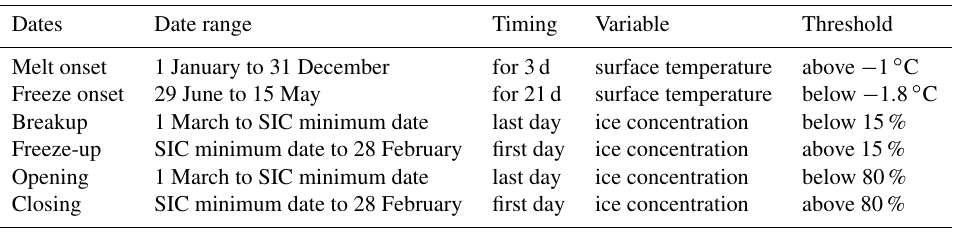
Table 1. Definitions of the seasonal transition dates, including the date range, timing criteria, variable, and threshold used. SIC is sea ice concentration. Definitions based on ice concentration are designed to be comparable to Steele et al. (2019) (note that day has been abbreviated to d when associated with a value).